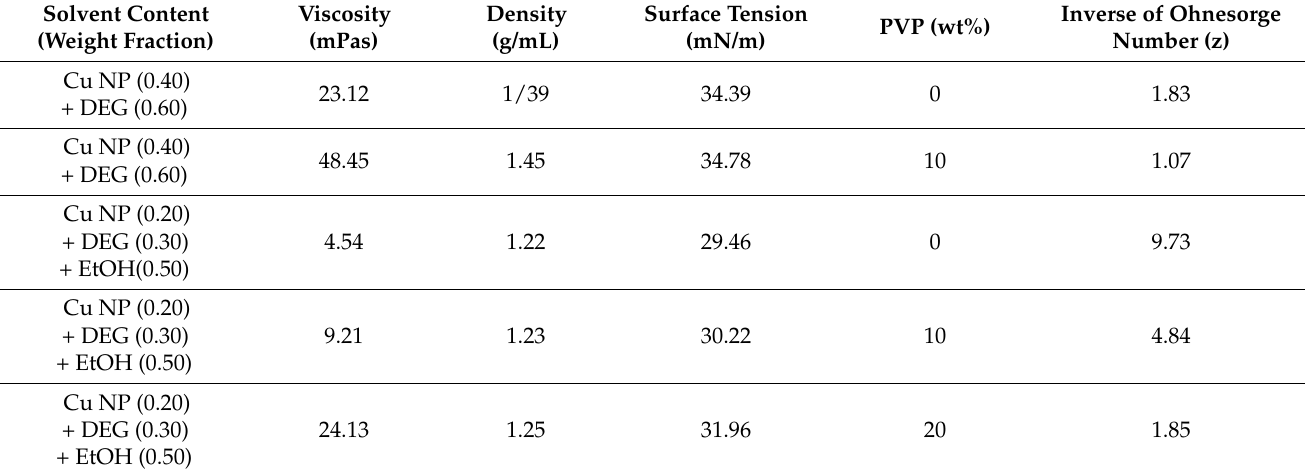
had a Z value between 1 and 10 before